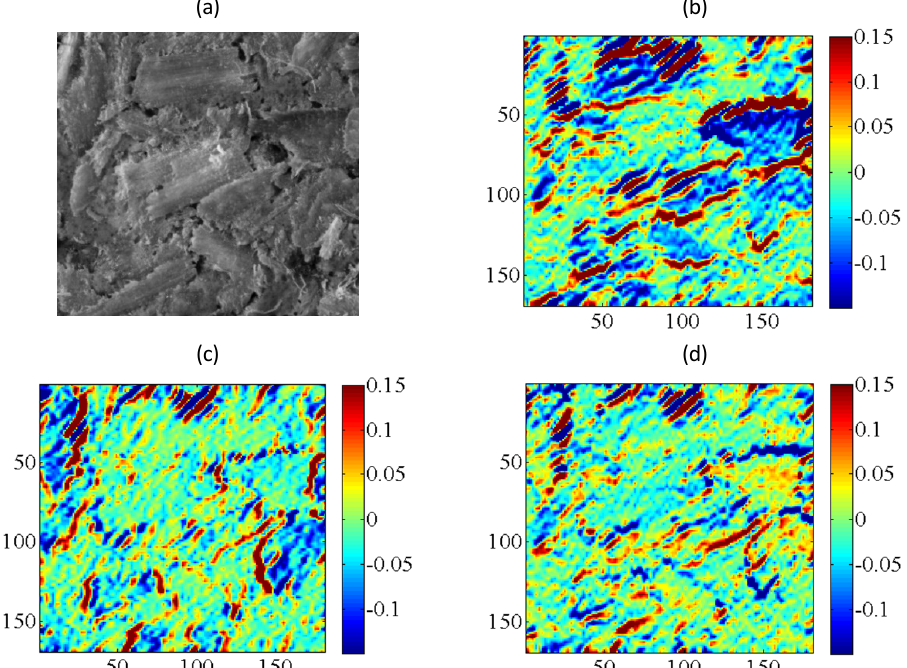
Figure 6. (a) saturated state and strains equivalent to 3% RH (b) (cid:2013) (cid:3051)(cid:3051) (c) (cid:2013) (cid:3052)(cid:3052) and (d) (cid:2013) (cid:3051)(cid:3052)